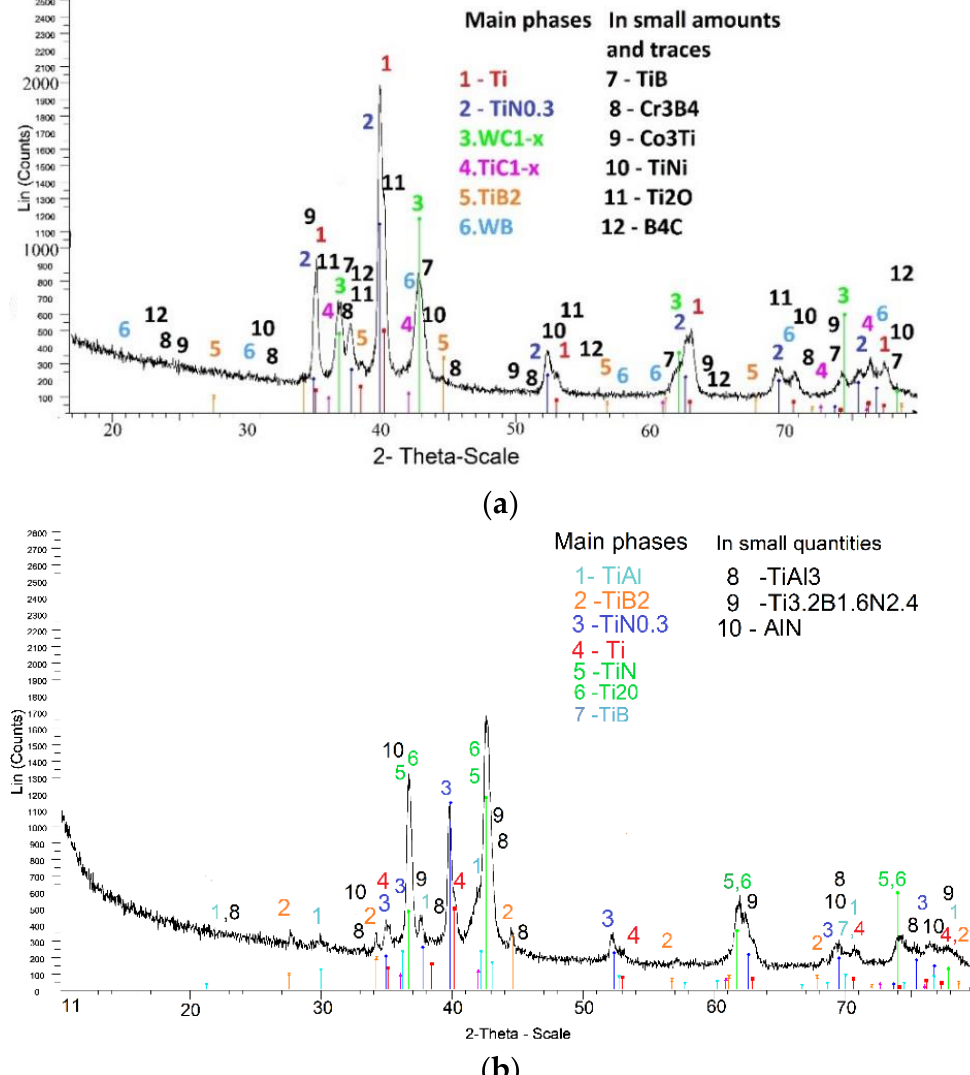
Figure 4. XRD diffraction patterns of coatings from ”KW” and TiB 2 –TiAl nano electrodes on Ti-GR2, E = 0.04 J. ( a ) coating from KW10T10B10 electrode; ( b ) coating from TiB 2 – TiAlnano electrode.